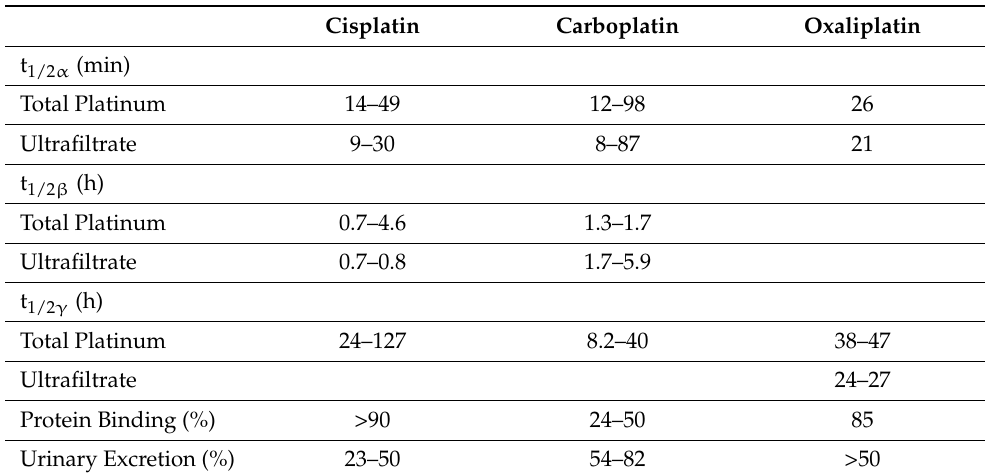
Table 1. Pharmacokinetics of cisplatin and its analogues following intravenous infusion. Re- printed with permission from [19]. Copyright Springer 2000.